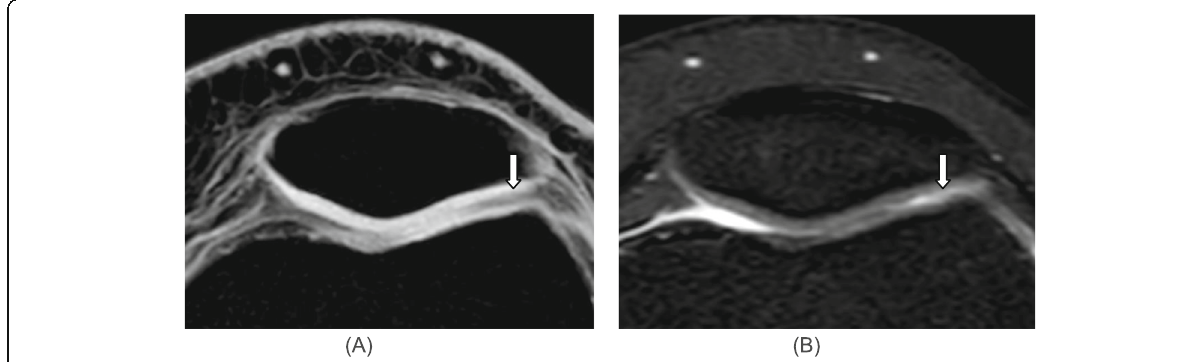
Fig. 1 Thirty-three-year-old man with knee pain, 3D WATC-s image ( a ) showing normal cartilage thickness displaying bright signal intensity on WATS-c image with superficial linear area of low signal intensity in lateral patellar articular facet in keeping with grade 1 chondromalacia. FS-PD image ( b ) show corresponding linear area of abnormal high signal intensity on low signal of cartilage with reversing signal seen